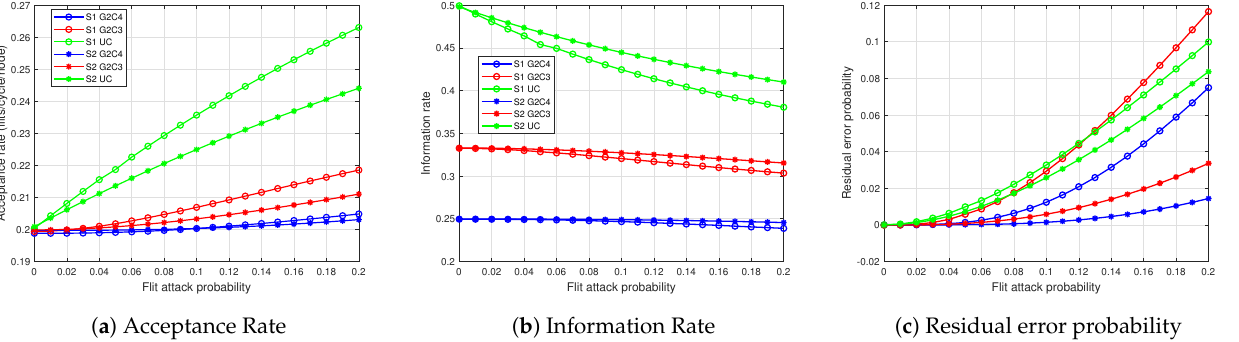
Figure A1. Simulation results for 8 × 8 2D mesh in scenario no drop, i.e., p a = p m .